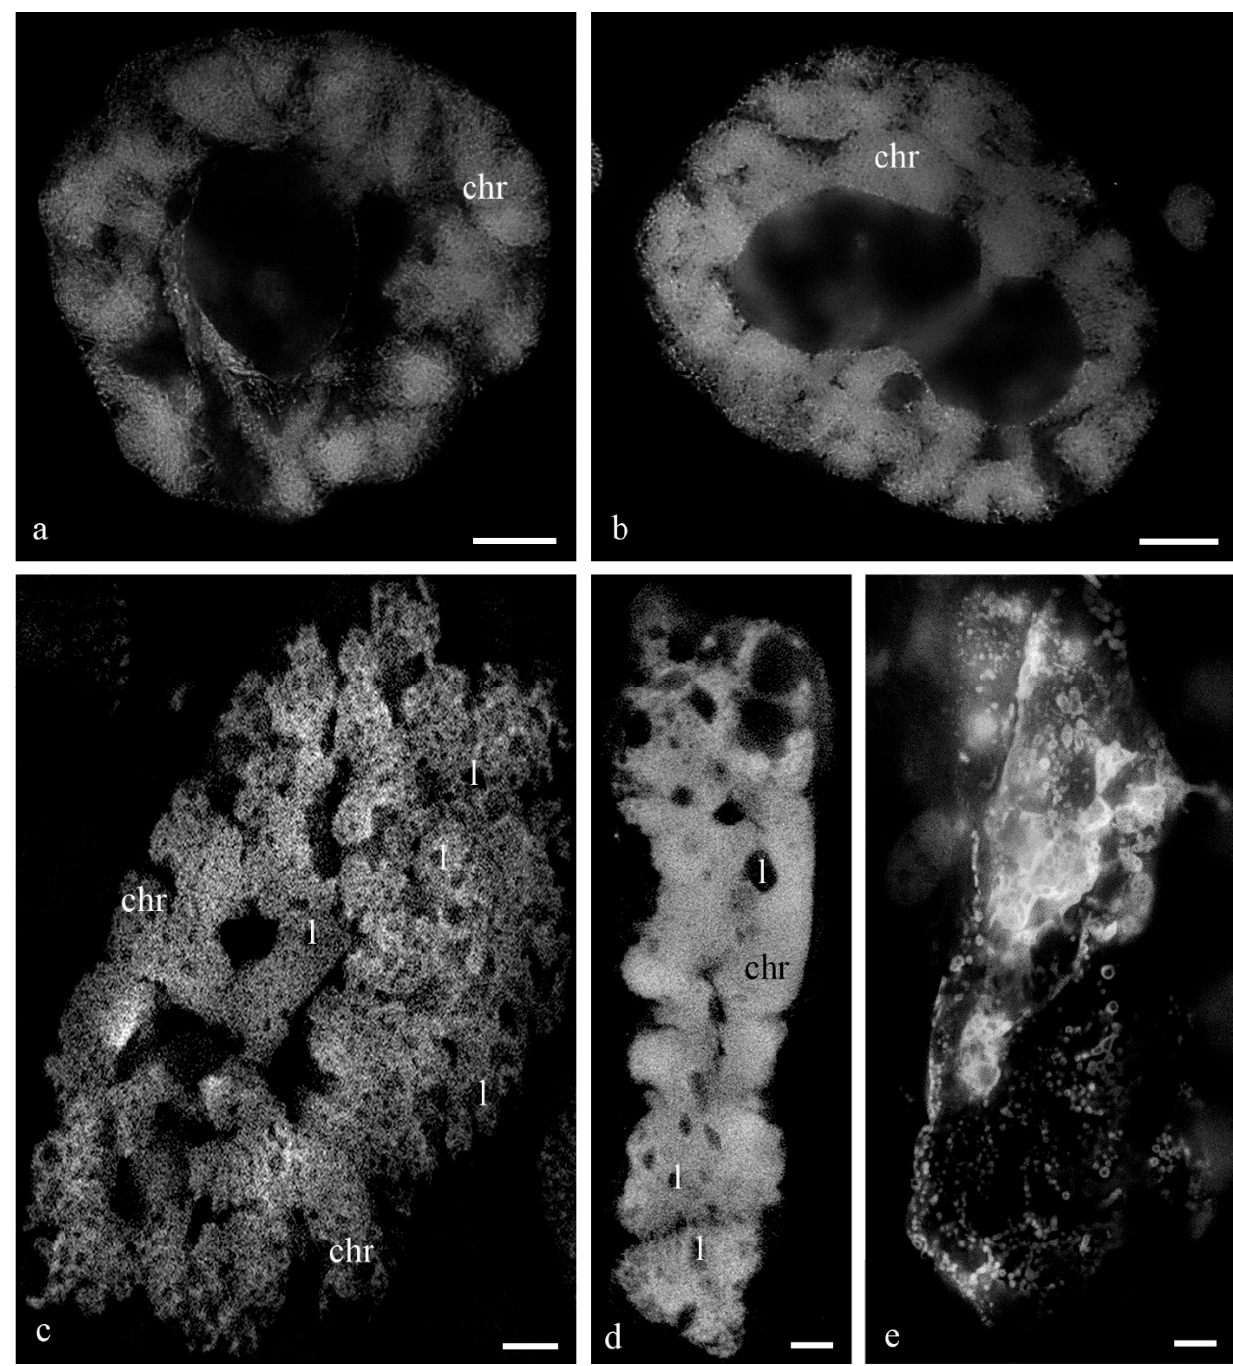
Figure 2. The nuclei of the antipodal cells of the wheat embryo sacs with giant polytene chromosomes at the stages of differentiation and programmed cell death. DAPI. The antipodal nucleus at the stage of middle differentiation, individual fibrils—chromatids are visible in the bodies of the polytene chromosomes ( a ); the nucleus of the antipodal cell at the late stage of differentiation, dense bodies of polytene chromosomes are visible ( b ); the nucleus at the middle stage of PCD, merged and united cellular polytene chromosomes ( c ); the nucleus at the late stage of PCD, dense united polytene chromosomes of the nucleus ( d ); fragmented nucleus at the late stage of PCD ( e ). chr—polytene chromosomes; l—lacunae in the region of polytene chromosomes. The scale is 10 µm.